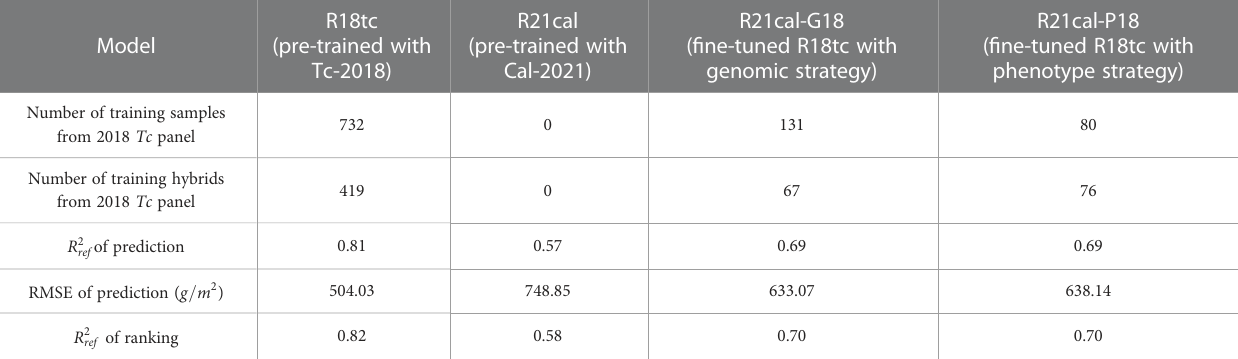
TABLE 5 Biomass prediction results obtained by the 4 models on the Tc panel in 2018 and Cal panel in 2021.